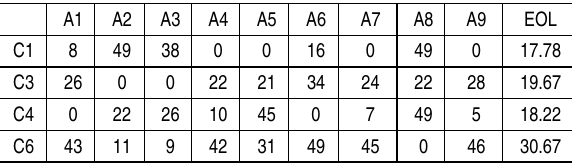
Table 31. Regret matrix with EOL